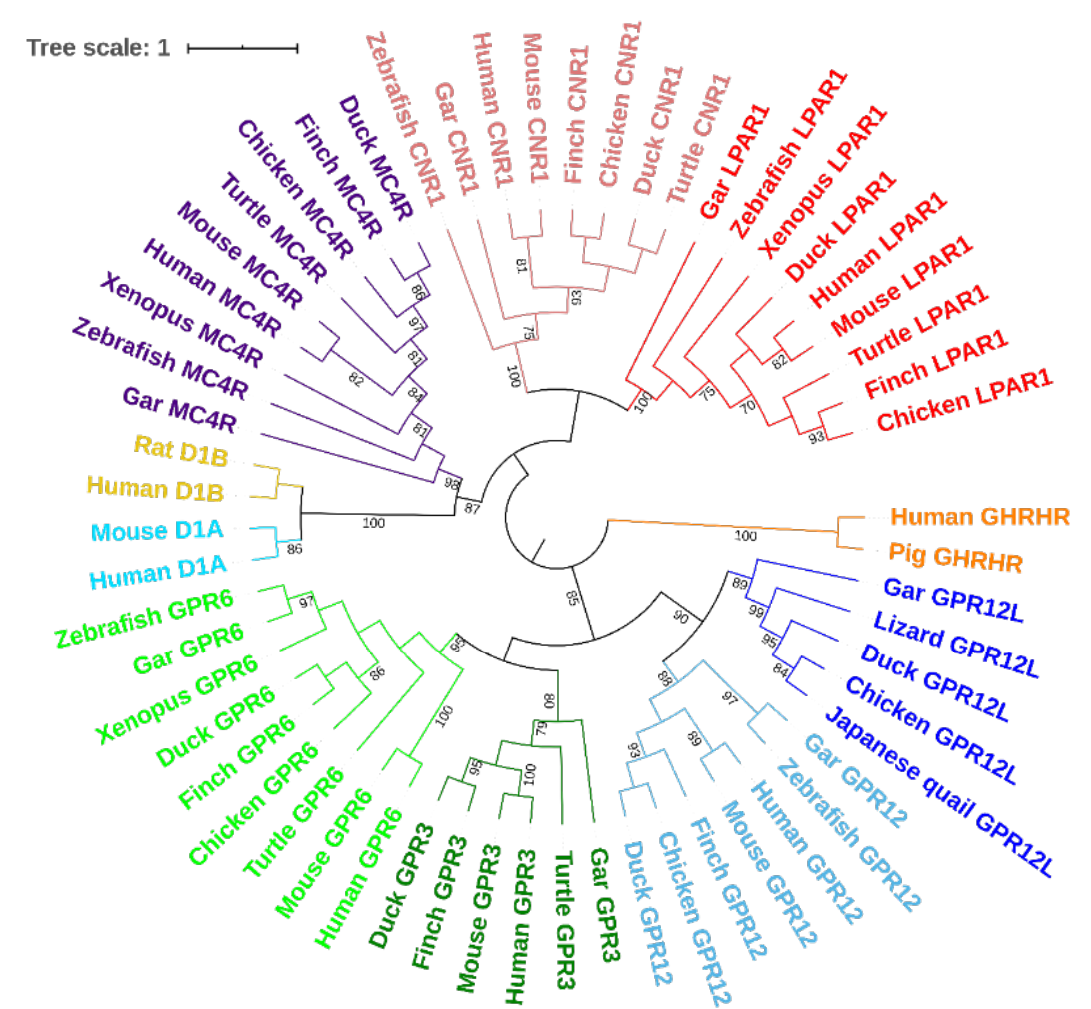
Figure 3. The phylogenetic tree of vertebrate GPR3, GPR6, GPR12, GPR12L, melanocortin 4 receptor (MC4R), cannabinoid receptor 1 (CNR1), and lysophosphatidic acid receptor 1 (LAPR1), dopamine receptor 1A (D1A), and dopamine receptors (D1B) constructed by MEGA7 software (maximum likelihood method). The GPR3 cluster is highlighted in deep green; the GPR6 cluster in orange; the GPR12 cluster in brown; the GPR12L cluster in purple.